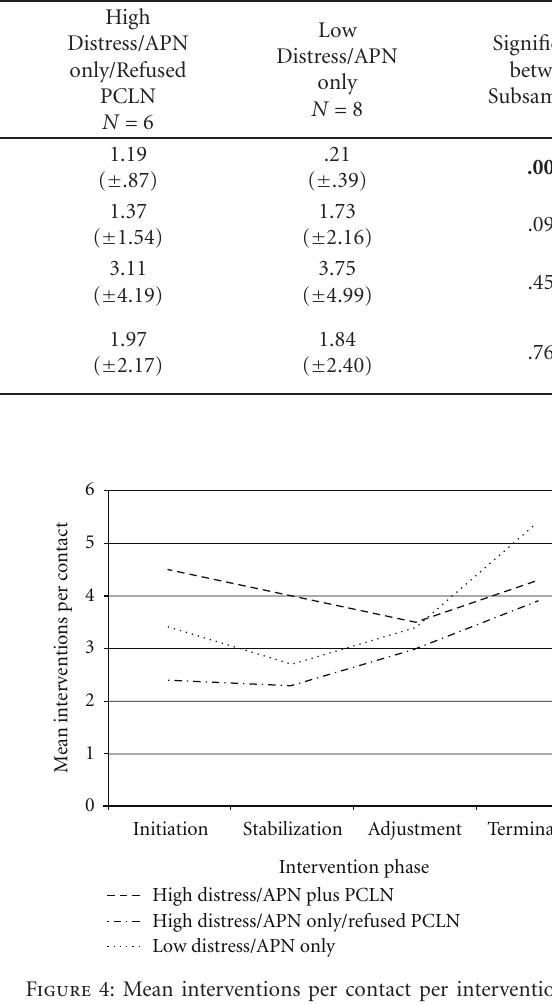
Table 4: Mean interventions per contact per domain.